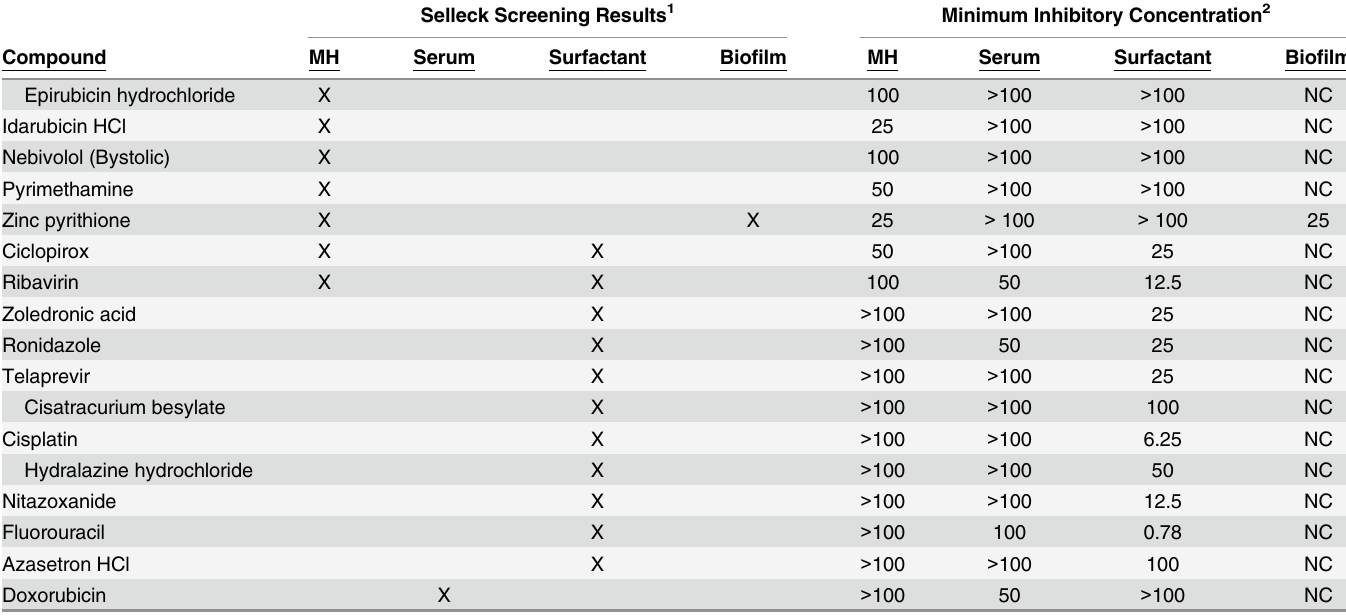
Table 4. Selleck library non-antibiotic